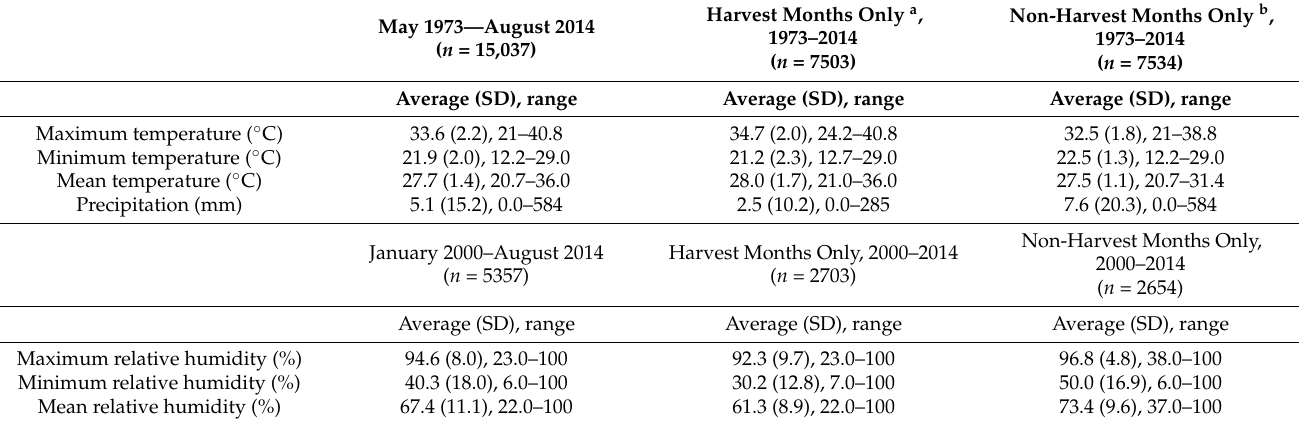
Table 1. Summary statistics for daily temperature, precipitation and relative humidity at ISA, 1973–2014 and